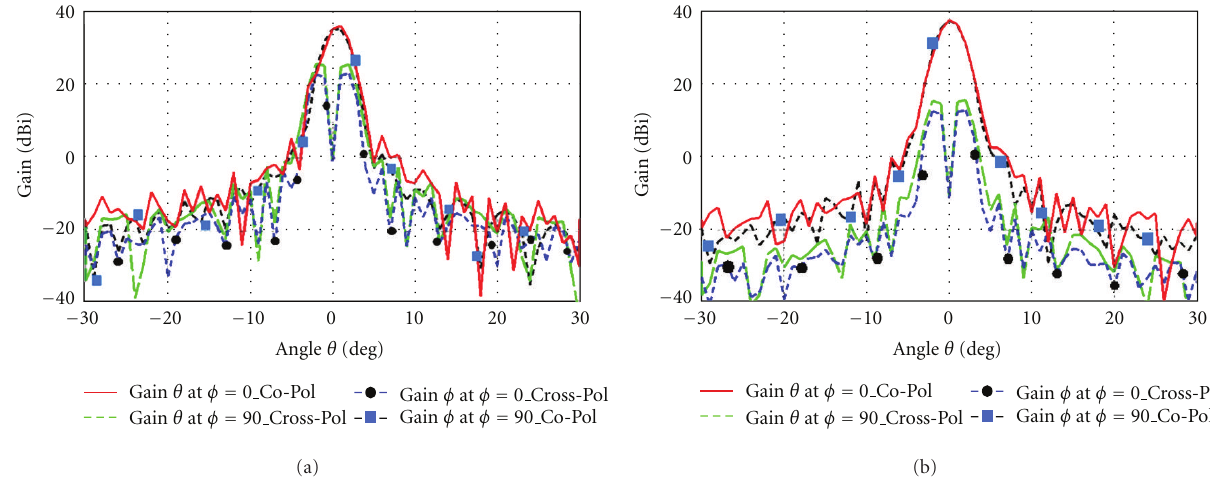
Figure 11: Reflector antenna radiation patterns at 7.73 GHz with the feedhorn mode combination of TE 11 + TM 01 + TE 21 for +90 ◦ phase